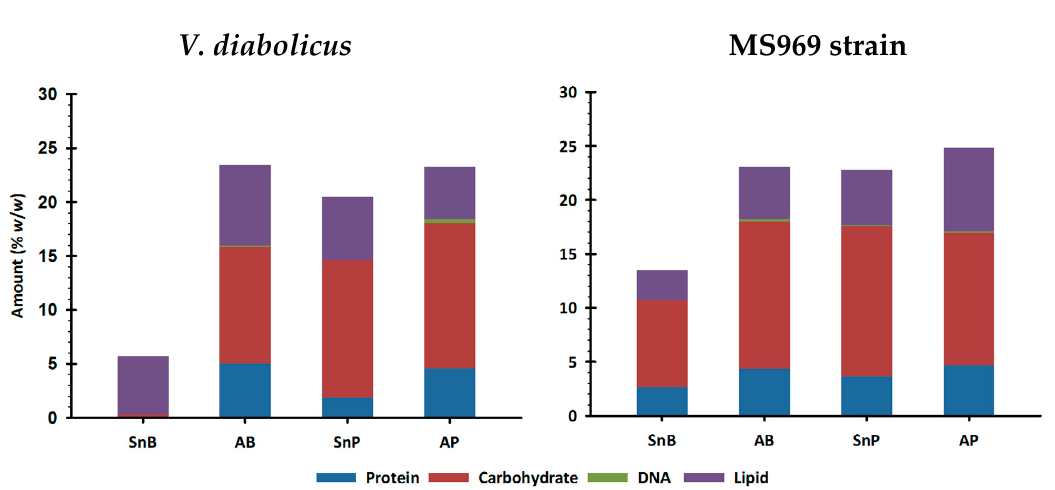
Figure 4. Recovery yield of each extract from 15 Petri dishes. ( a ) Amount of recovered cells. ( b ) Yield (mg) recovered after freeze drying or evaporation calculated for the whole biofilm or planktonic sample.